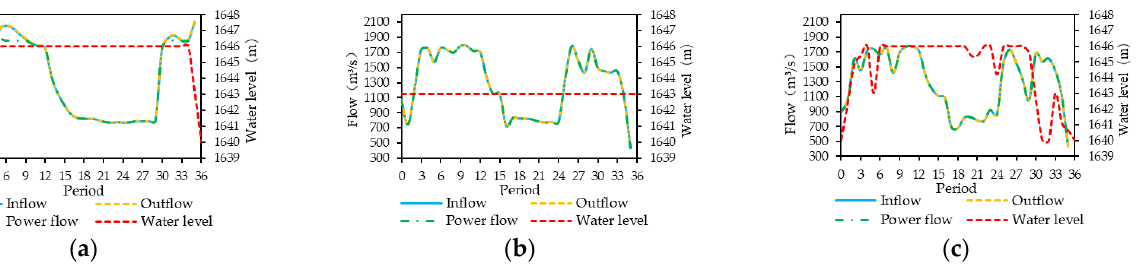
Figure 8. Operation hydrographs of the Jindong Reservoir using ( a ) Scheme 1, ( b ) Scheme 2 and ( c ) Scheme 3.